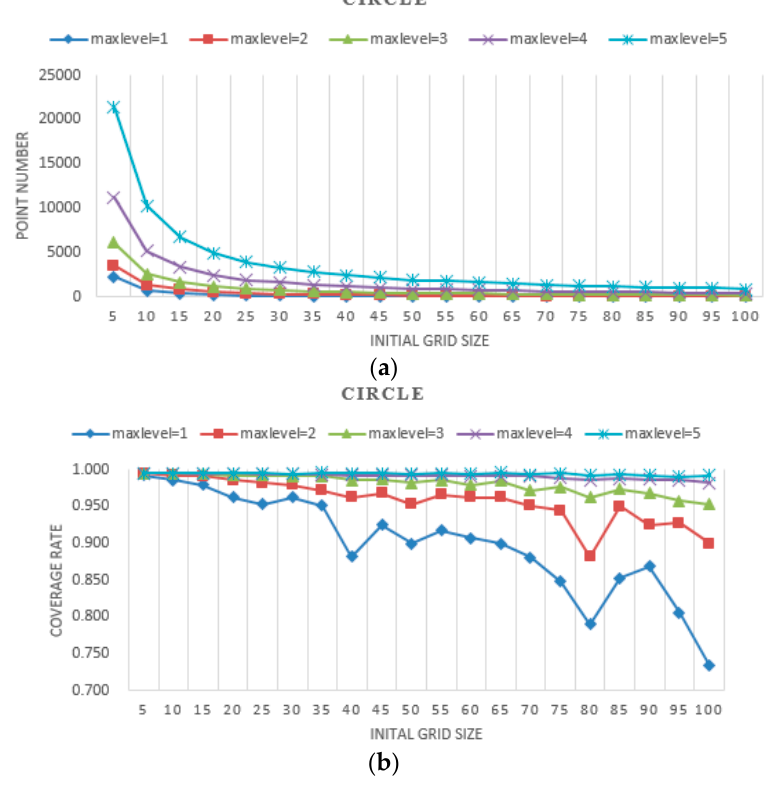
Figure 8. Results for the circle with different initial grid sizes and max levels. ( a ) point number; ( b ) coverage rate.